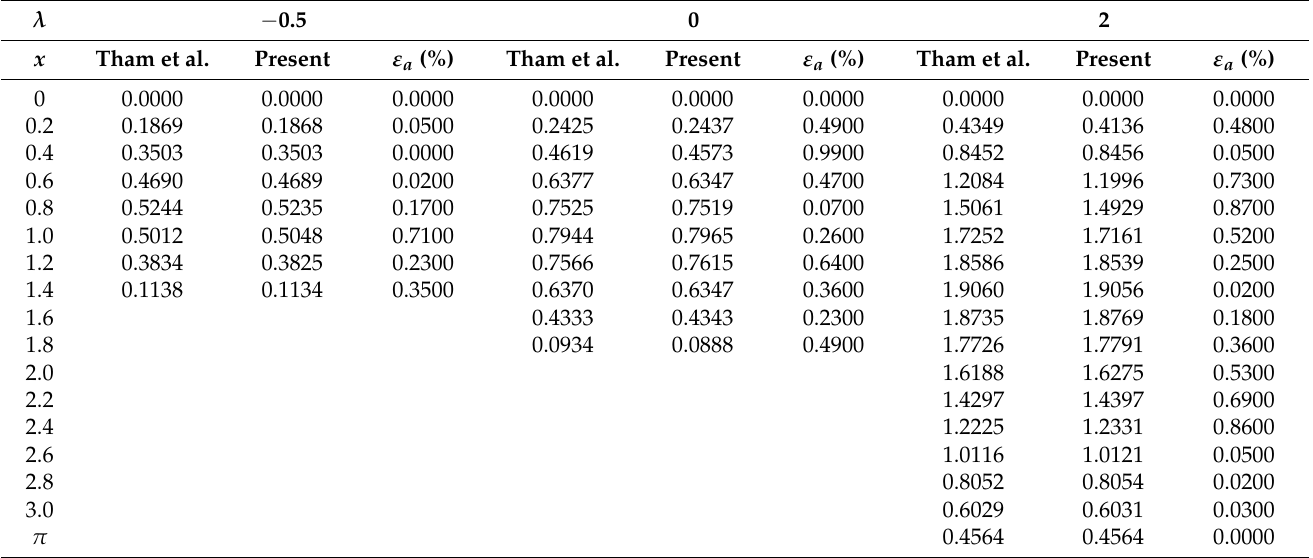
Table 2. Validation of Re 1/2 C f by comparing it with Tham’s et al. [70] findings for different values